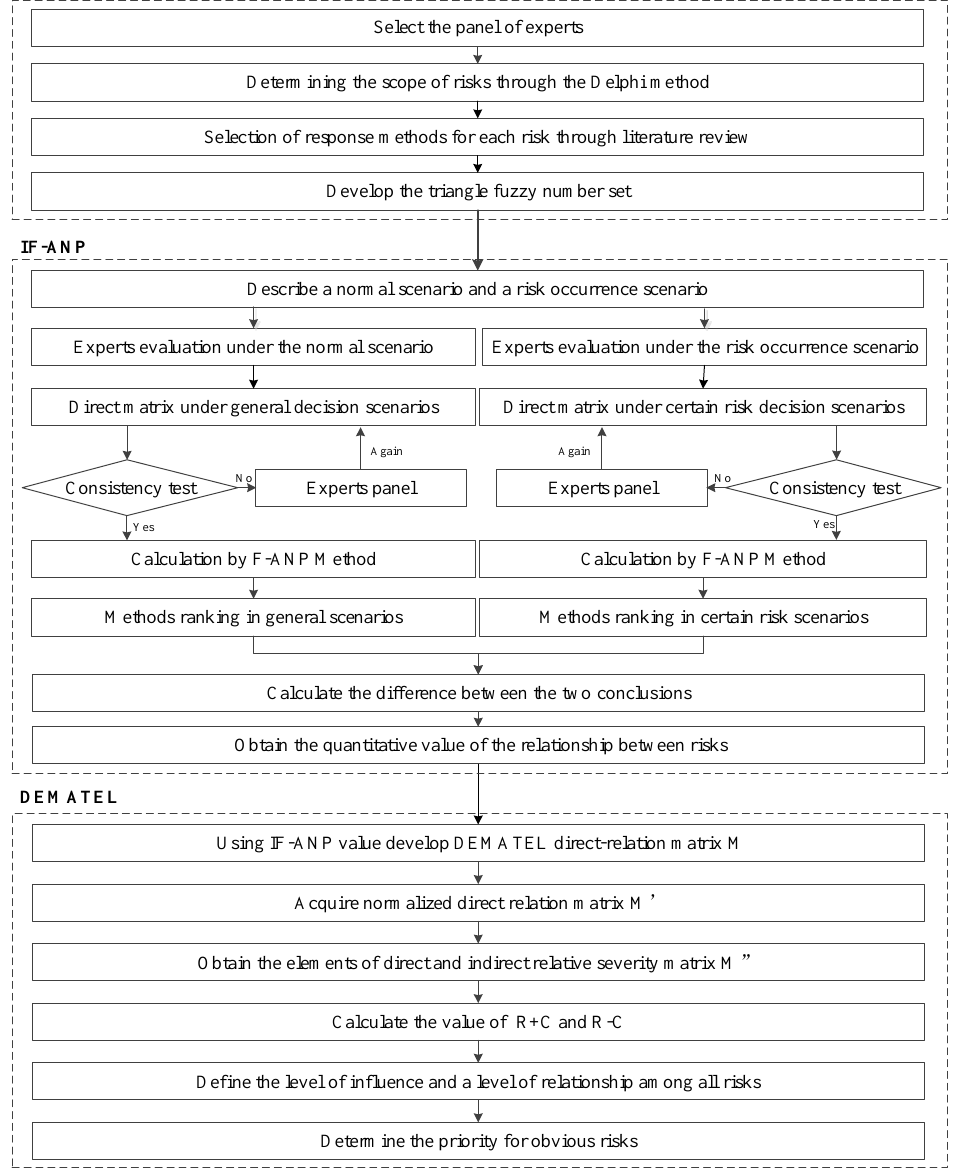
Figure 1. The framework of this